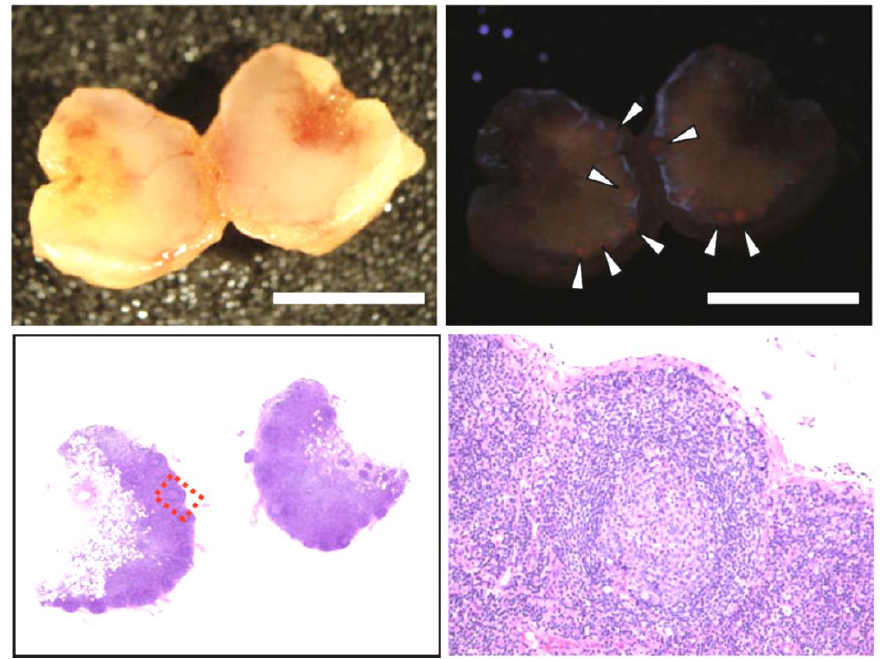
Figure 7 . Non-specific deposition of protoporphyrin IX (PpIX) in lymphoid follicles in a non-meta- static lymph node (LN). “Reprinted/adapted with permission from Ref. [15]. 2013, Springer”. 5-ALA hydrochloride (15 mg/kg body weight) was administered orally 2 h before anesthesia induction. A white-light image (upper left panel), a fluorescence image (upper left panel) (excitation: 405 nm; emission: 430 nm), and hematoxylin – eosin (HE)-stained sections (lower panels) are depicted. Ar- rowheads show red fluorescent nodules originating from accumulated PpIX in lymphoid follicles. The HE-stained images include the lymphoid follicles identical to the fluorescent nodules. The lower right figure is an enlarged drawing of the boxed field shown in the left lower figure. Scale bars: 3 mm.